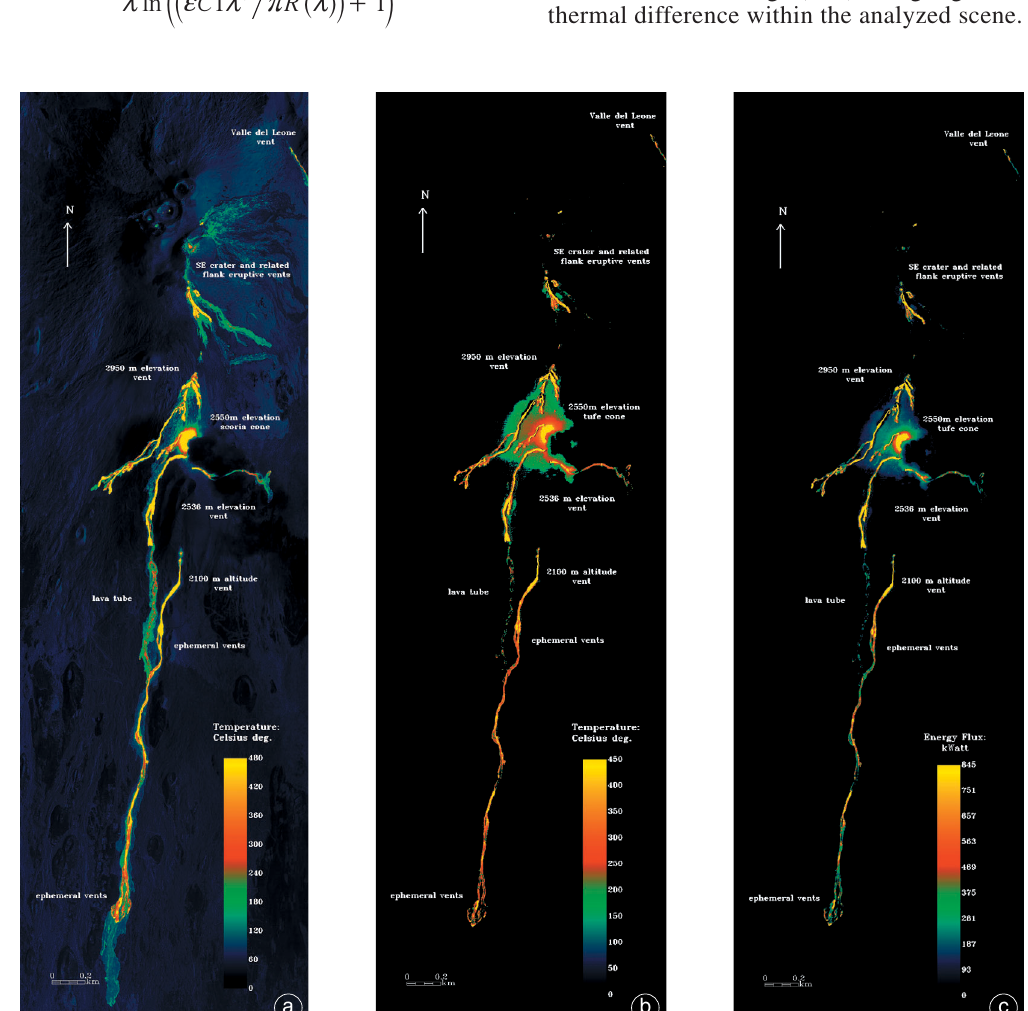
Fig. 3a-c. a) Principal components transformation on the MIVIS thermal infrared bands and integrated tem- perature mapping of the lava flows. b) Crust temperature distribution retrieved by using the dual-band technique. c) Energy flux calculated for the radiant